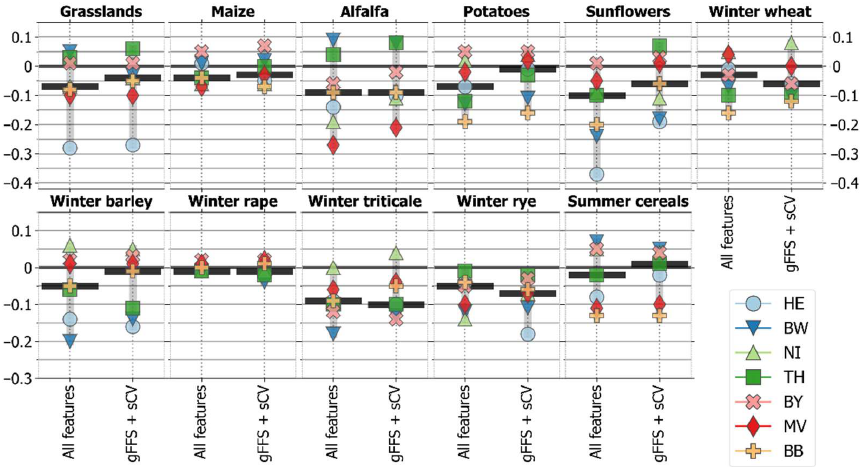
Figure 9. Crop-specific accuracy losses in the target systems for models using a combination of optical and SAR features (S1+S2). The abbreviation keys are provided in Table 2. For a complete plot with three sensor groups, check Supplementary Material D.